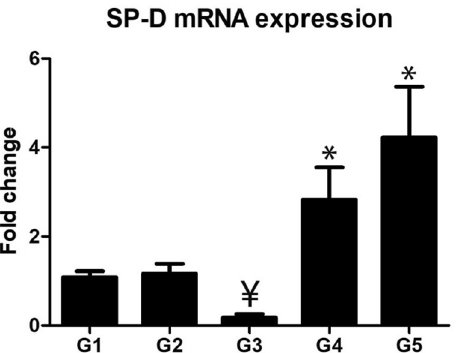
Figure 6. Relative expression of SP-D within the lung tissues which decreased in G3 and markedly increased in G4 and G5. Sign ¥ indicates significance in comparing with G1 (P < 0.005) and sign * indicates significance in comparison with G3 (P <